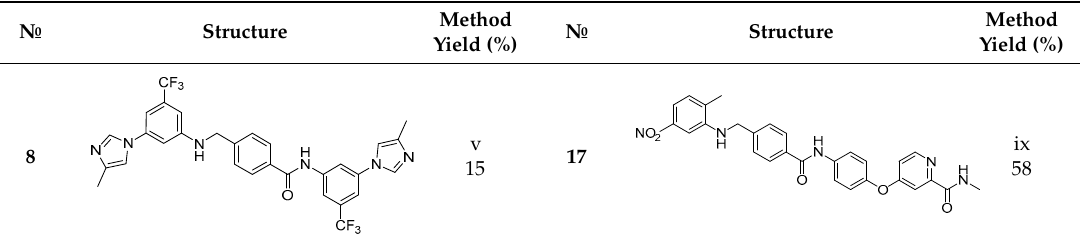
Table 1. Synthesis methods and structures of obtained compounds 8 – 25 .